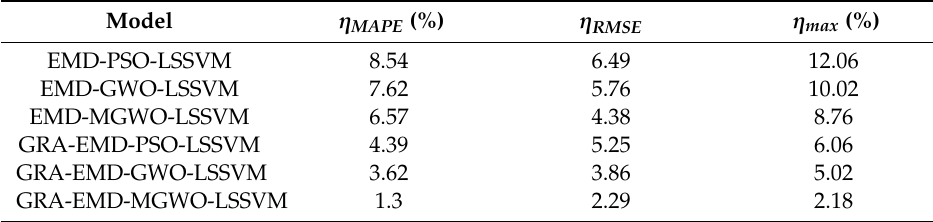
Table 4. Comparison of di ff erent prediction